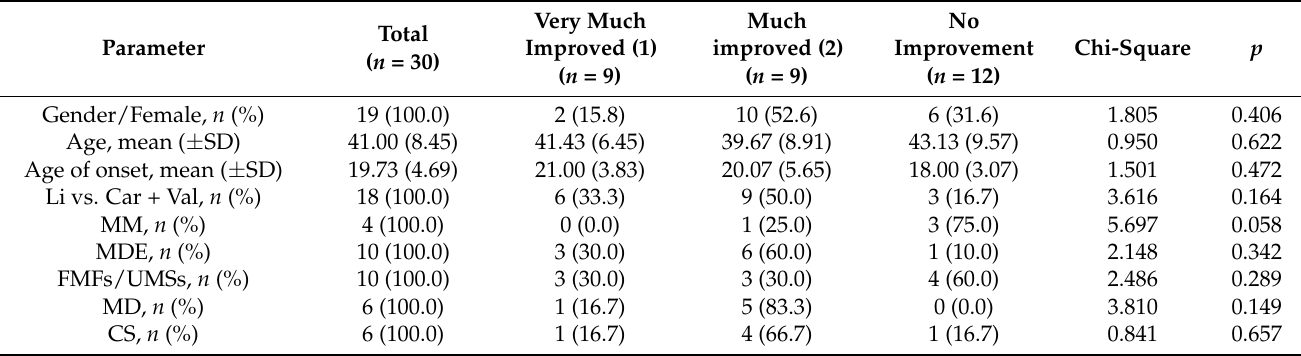
Table 2. Acute ECT response measured with the CGI-BP-I scale in relation to demographic variables (female gender, age, age at onset), treatment, and illness characteristics (index episode, presence of catatonic